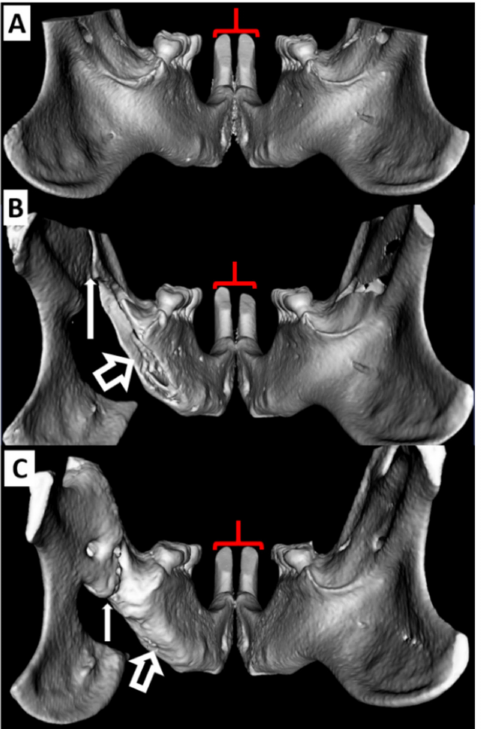
Figure 6. Reconstructed µ CT images showing effects of left narrow gap CRO on rat incisors: ( A ) Baseline image. ( B ) One week following CRO (thin arrow). Note the incisor ipsilateral to the defect is longer (brackets). ( C ) At week 3 the defect has healed in a bony union (thin white arrow) in close association with restoration of incisor length and morphology. Note the bony deposition in the region of the reserve crown (compare open arrow in plate C to plate B ). µ CT = micro computed tomography, CRO = complete ramus osteotomy.